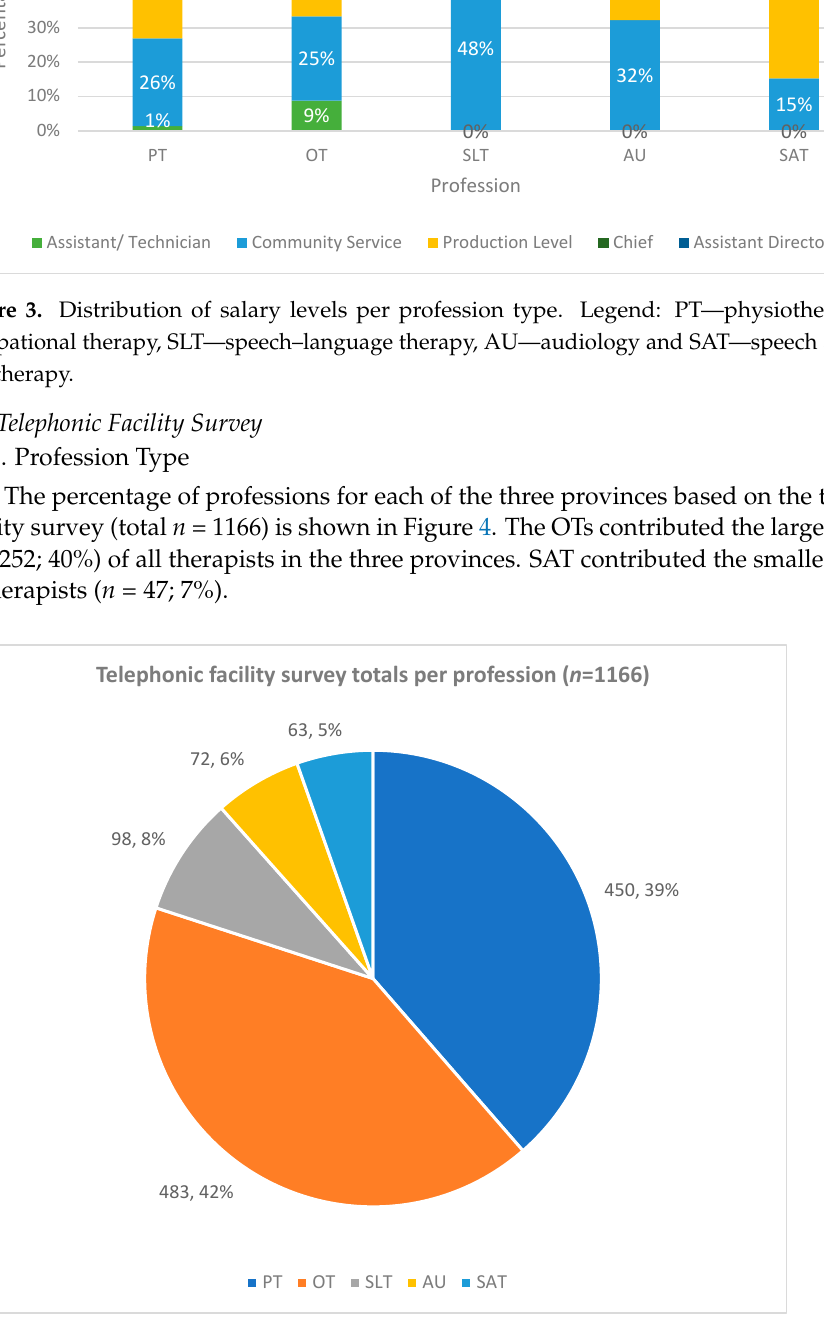
Figure 4. Total therapists based on the telephonic facility survey total number of three provinces and percentage of profession type ( n ;%). Legend: PT—physiotherapy, OT—occupational therapy,